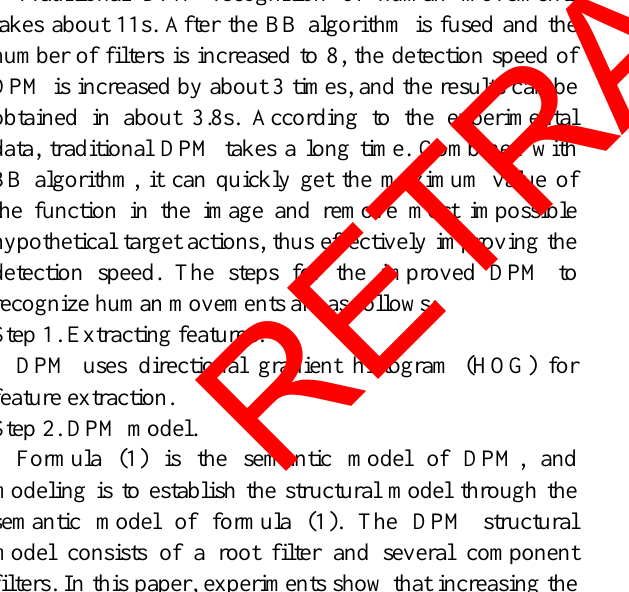
Shallow multiscale